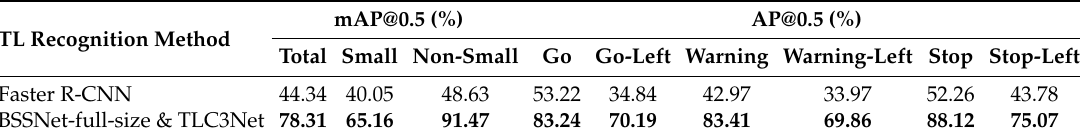
Figure 4. Average TL recognition performances according to dataset shift. Table 5. TL recognition performances on test dataset in LISA database.